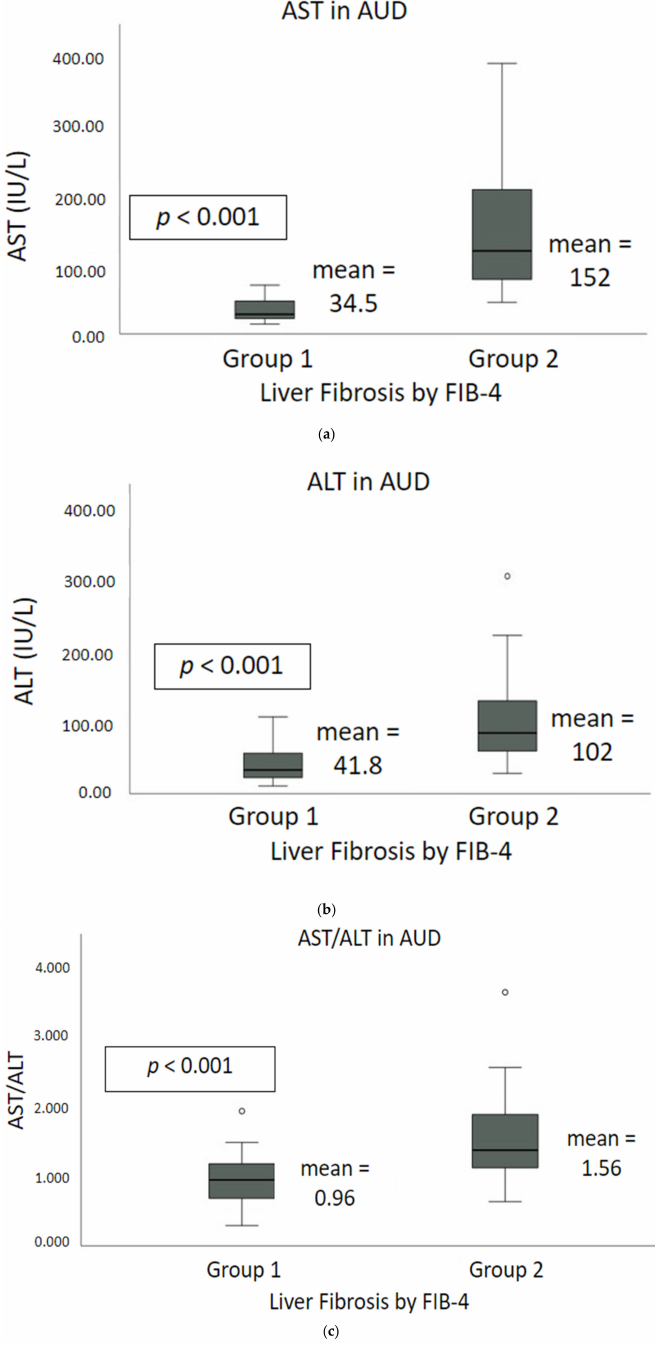
Figure 3. Liver injury markers: AST, and ALT in alcohol use disorder (AUD) patients in Gr.1 compared to Gr.2. ( a ) AST; ( b ) ALT; ( c ) AST/ALT, respectively, in AUD patients without versus with fibrosis. ◦ outlier